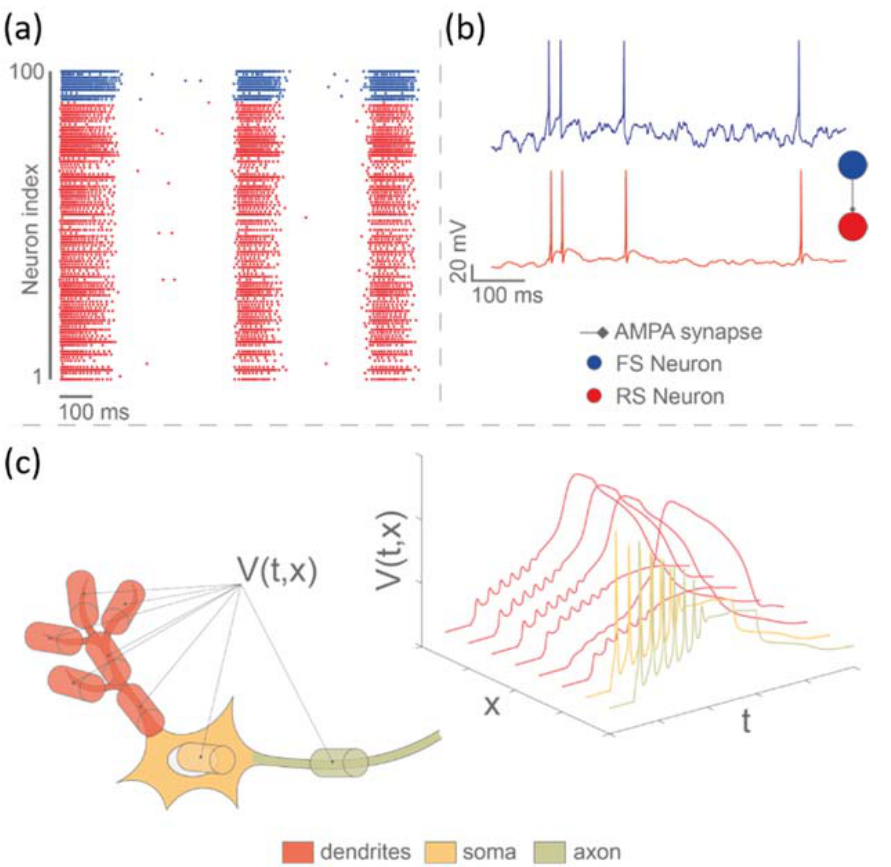
Figure 7. Bio-mimetic approach for the SNN. ( a ) Raster plot of a bio-mimetic SNN implemented on FPGA that is constituted of 100 cortical neurons distributed in a 10–90% ratio of fast spiking (FS) (blue) and regular spiking (RS) (red) neurons. FS neurons are inhibitory cortical neurons. RS neurons are the excitatory ones. The neurons are connected via synapses describing the electrical activity of AMPA and GABAa receptors. The different parameters of the model and network are tuned to obtain an activity similar to the one obtained in biology. ( b ) Membrane potential of two cortical neurons (Hodgkin-Huxley—HH model and synaptic noise) connected via AMPA synapse computed by FPGA. ( c ) Representation of the spatial structure of the neuron using compartmentalization (multicompartmental modeling).